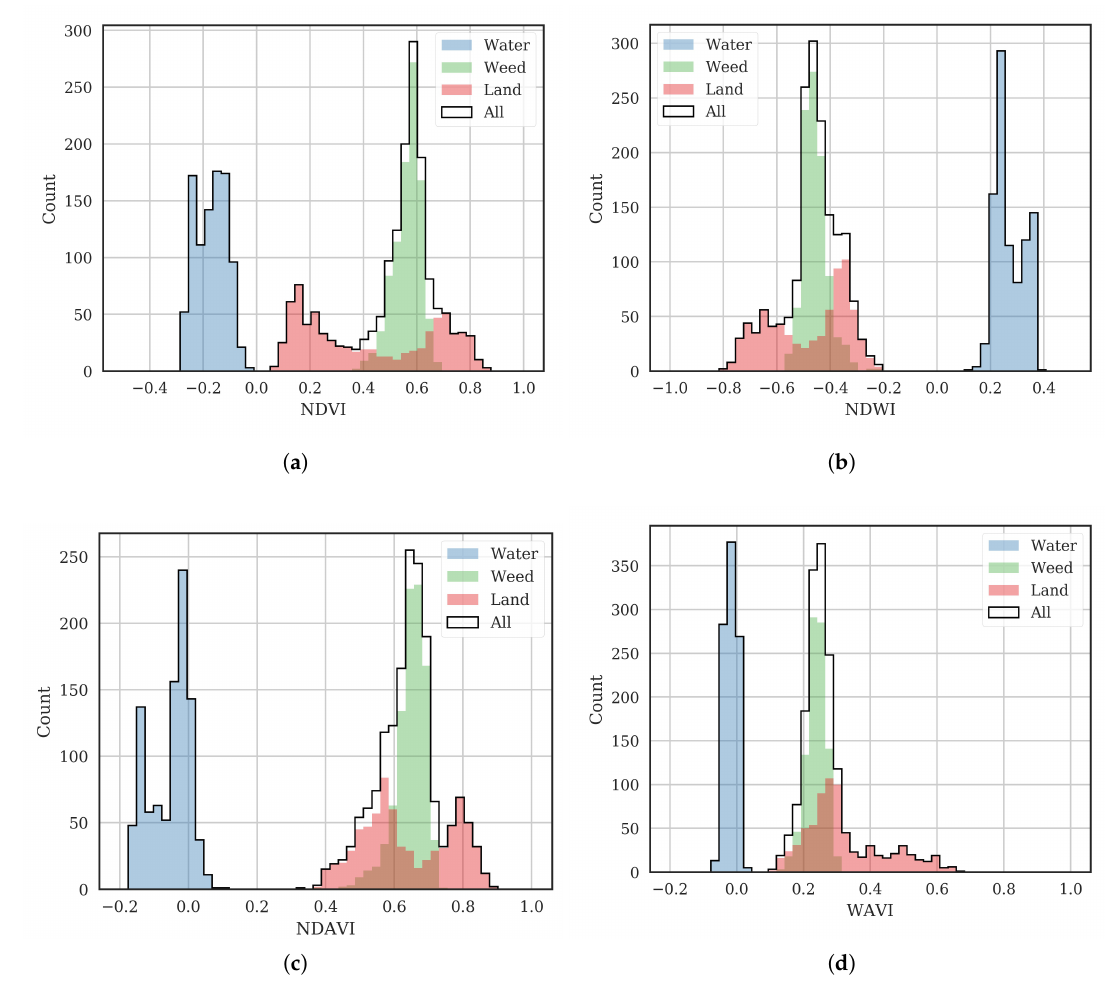
Figure 5. Vegetation index histograms for each of the classes for the 2 July image of the C1 channel.